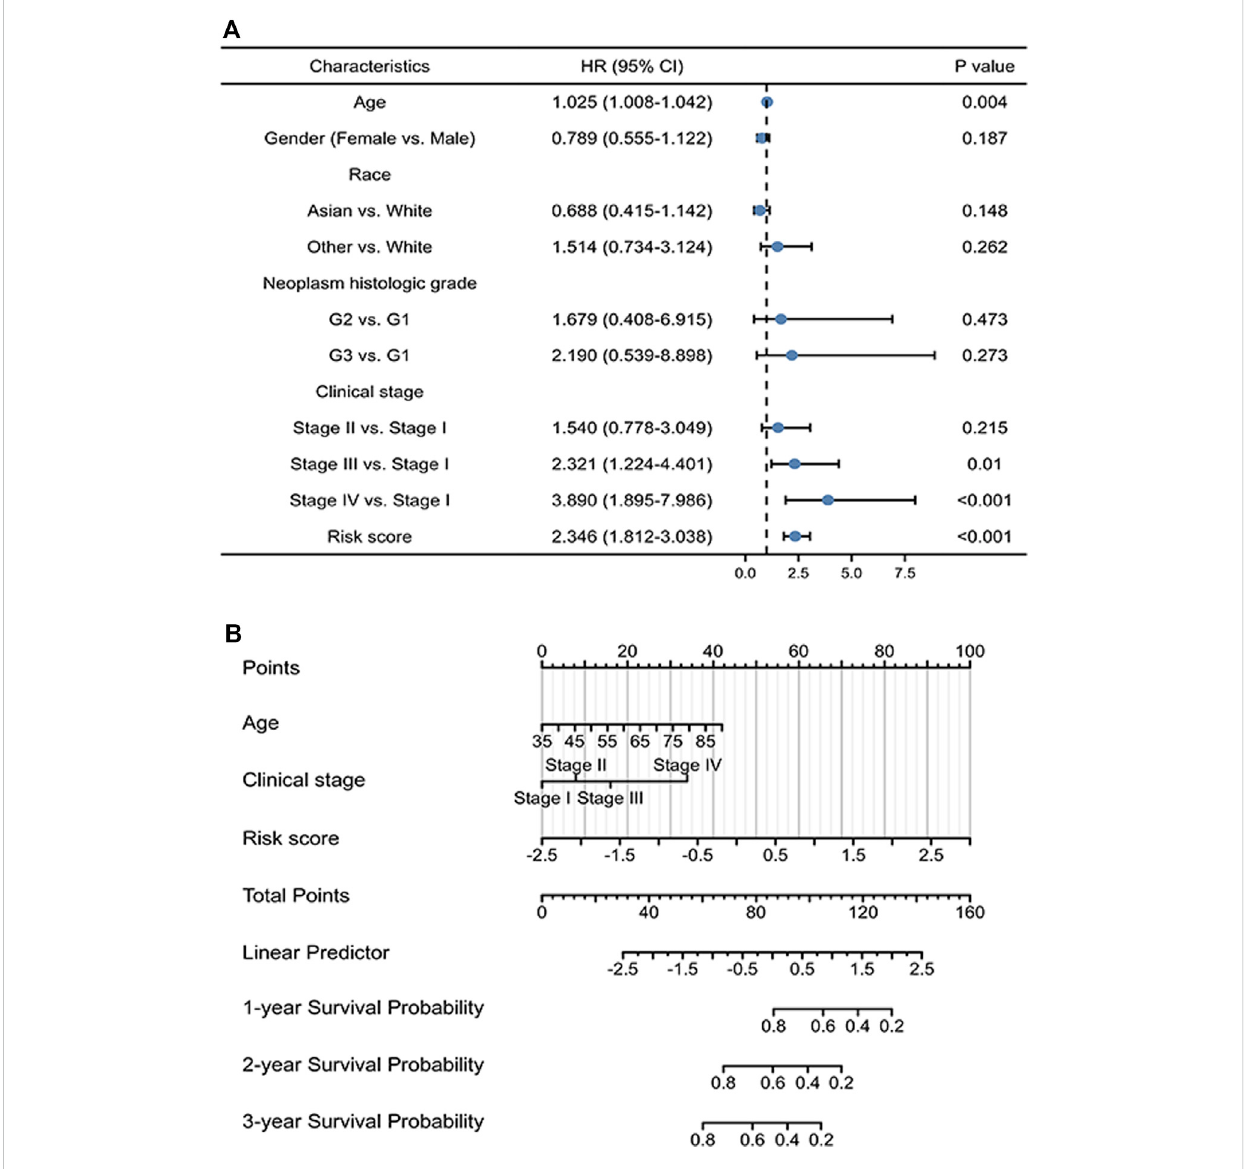
FIGURE 4 Prognostic value of the ICD-related lncRNA signature. (A) Multivariate Cox regression of patient characteristics and the signature as a whole. (B) Nomogram of the risk model with clinical